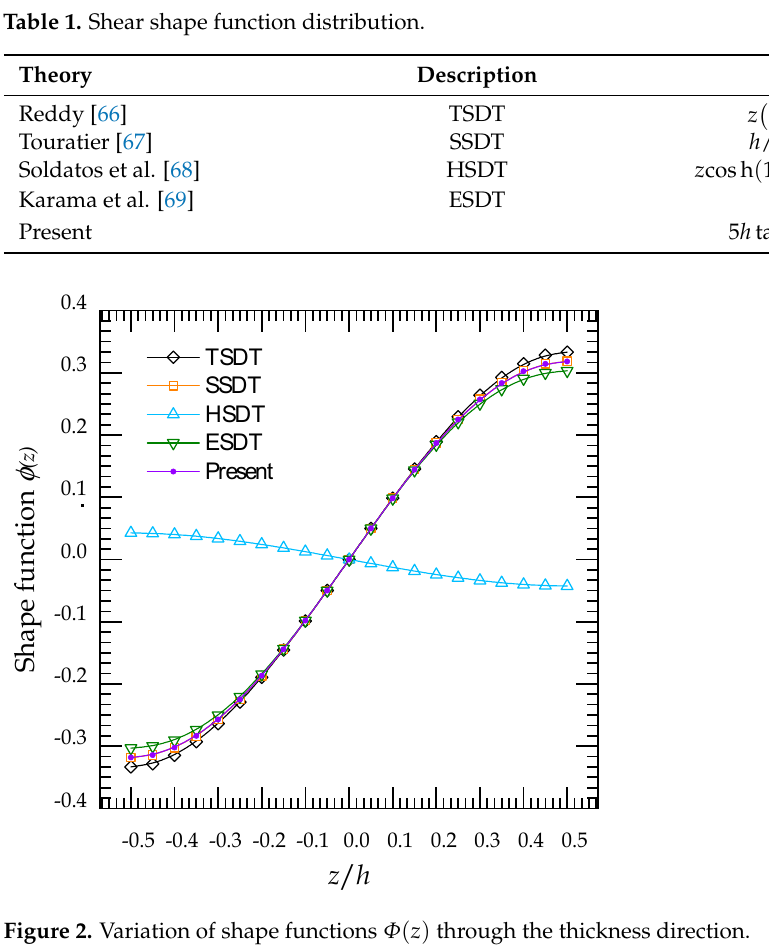
Figure 2. Variation of shape functions Φ ( z ) through the thickness direction.